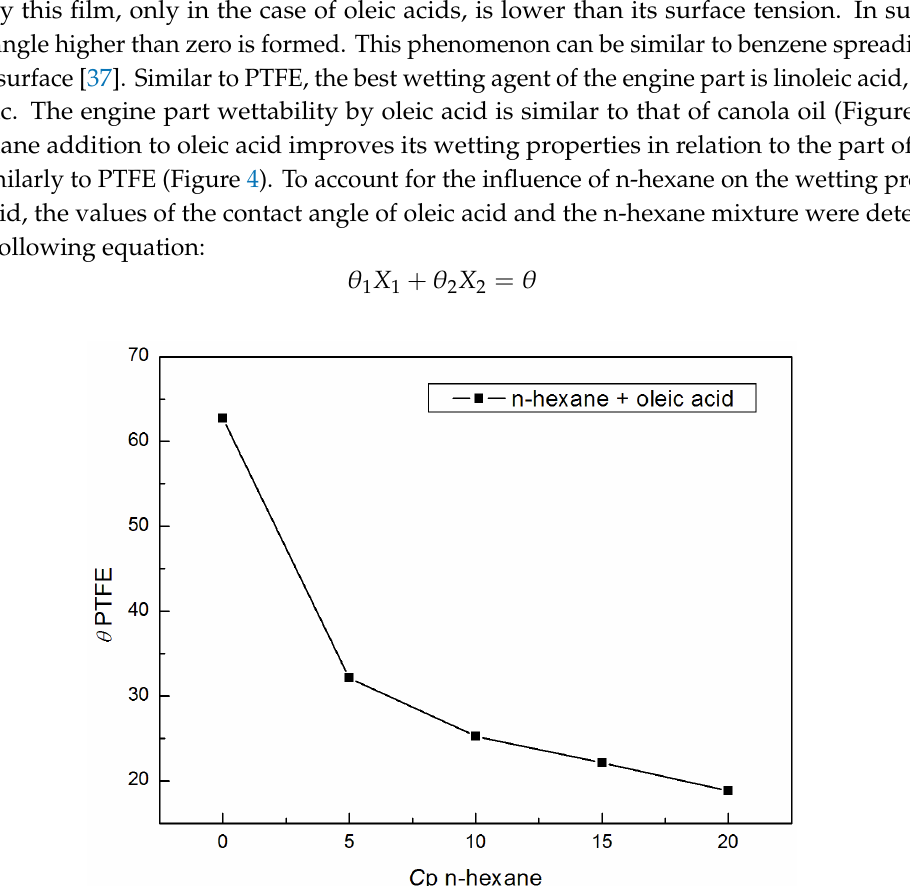
Figure 5. The values of n-hexane mole fraction in n-hexane and oleic acid mixture vs. its percentage concentration ( C p ).